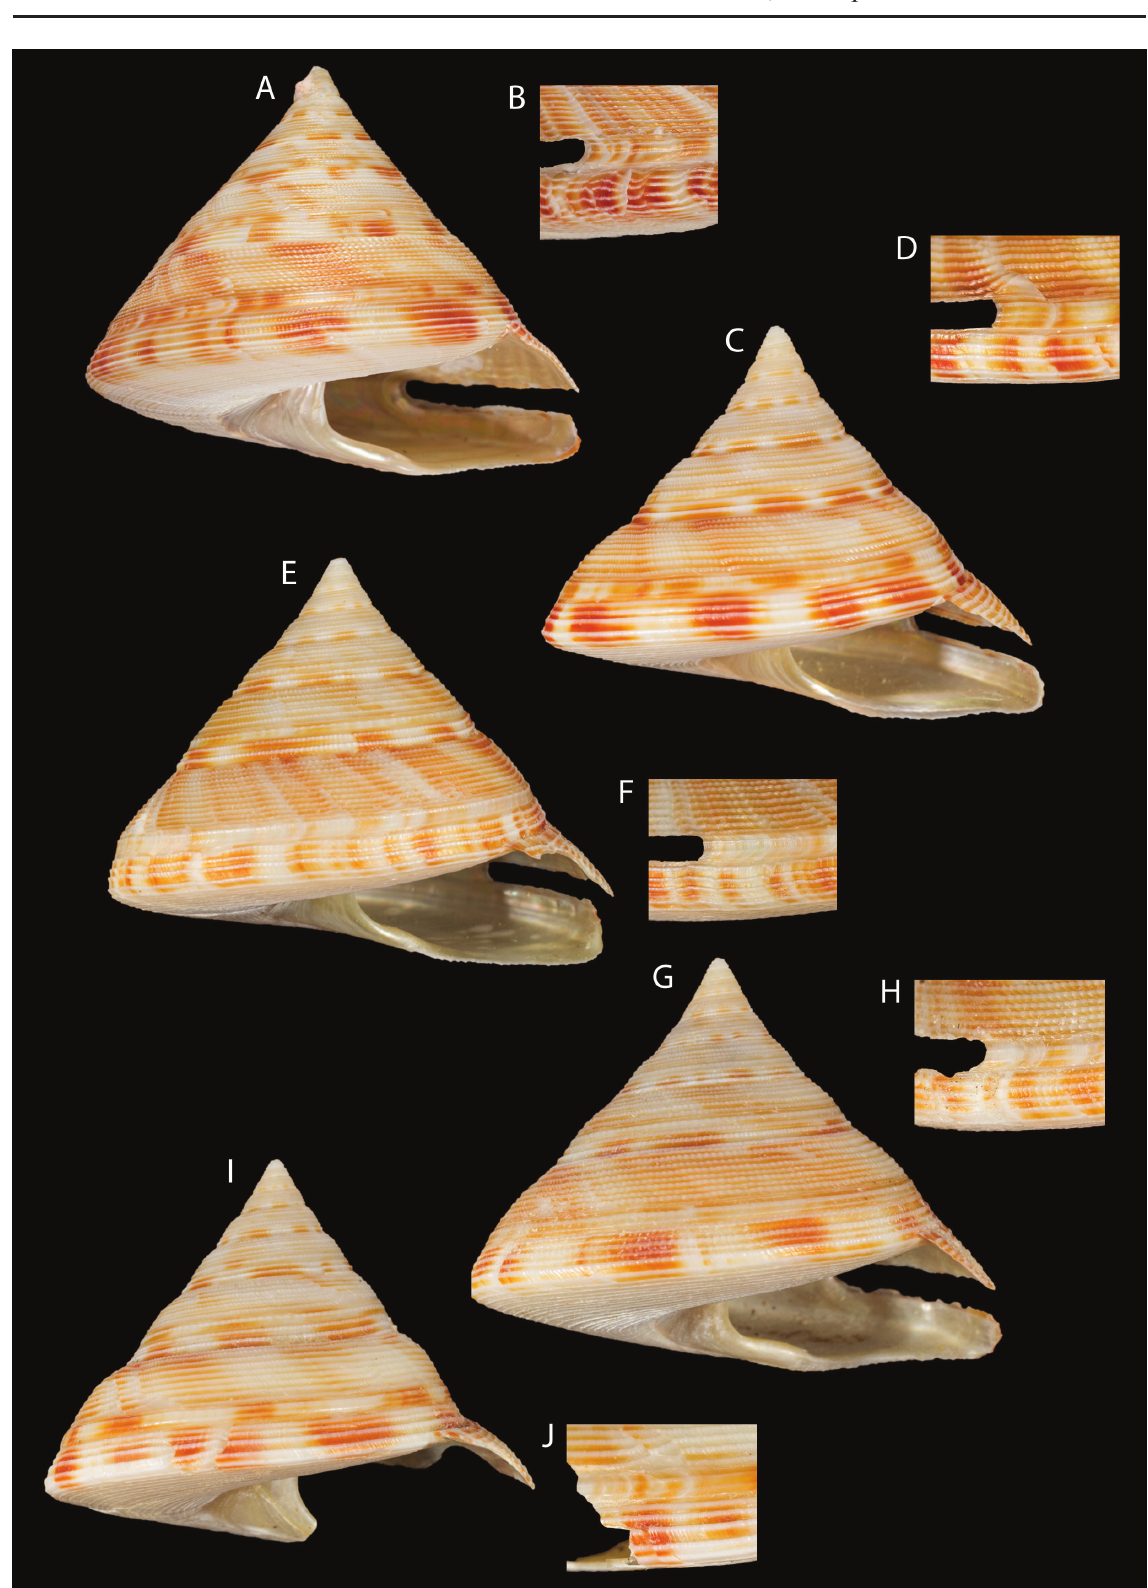
Fig. 6. Perotrochus pseudogranulosus sp. nov., paratypes. A–B . Mnhn-iM-2007-32058 (h = 53